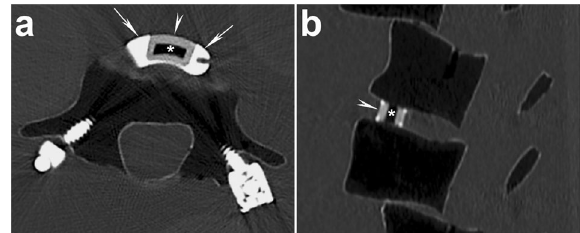
Fig. 2 Appearance of titanium cage on dual-energy CT (DECT) imaged in a synthetic polyurethane foam/ hydroxyapatite lumbar spine model. a Axial and ( b ) sagittal reformatted 100 keV virtual mono- chromatic images (VMIs) reconstructed from a DECT scan of the spine show that the lattice portion has high density (arrowheads) but that is less than the solid titanium portions (marked by the arrows). The center is hollow (asterisks). Scan acquired using a rapid kV-switching CT scanner (Revolution CT, GE Healthcare) Table 1 Radiographic assessment of interbody fusion by the method of Brantigan, Steffee, and Fraser (BSF)[53] BSF-1: Radiographical pseudarthrosis is indicated by collapse of the construct, loss of disc height, vertebral slip, broken screws, displacement of the carbon cage, or signi fi cant resorption of the bone graft, or lucency visible around the periphery of the graft or cage. BSF-2: Radiographical locked pseudarthrosis is indicated by lucency visible in the middle of the cages with solid bone growing into the cage from each vertebral